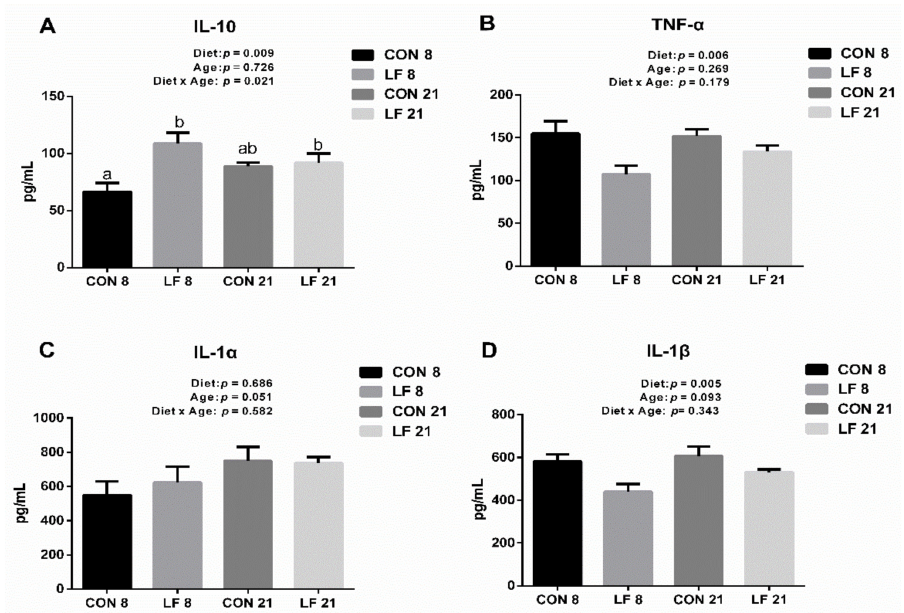
Figure 4. E ff ects of lactoferrin on cytokines levels in the serum of suckling piglets. ( A ) IL-10, ( B ) TNF- α , ( C ) IL-1 α , ( D ) IL-1 β . Values are means, standard errors represented by vertical bars, n = 6 per treatment. a-b Di ff erent letters mean significantly di ff erent for di ff erent groups at p < 0.05. Control group on day 8 (CON 8); Lactoferrin group on day 8 (LF 8); Control group on day 21 (CON 21); Lactoferrin group on day 21 (LF